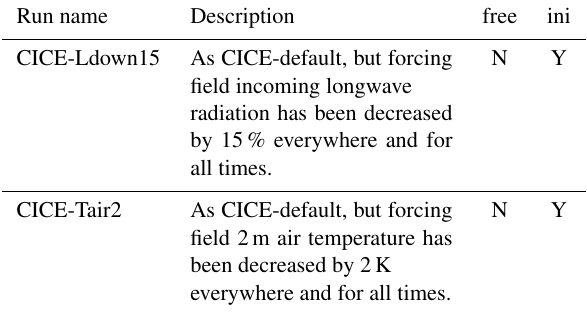
Table 2. Sensitivity simulations exploring the impact of uncertainty in atmospheric forcing data. “Free” indicates multi-year simulations from 1980 to 2017; “ini” indicates seven 1-year-long simulations starting in mid-November with CS2 sea ice thickness (2010/11 to